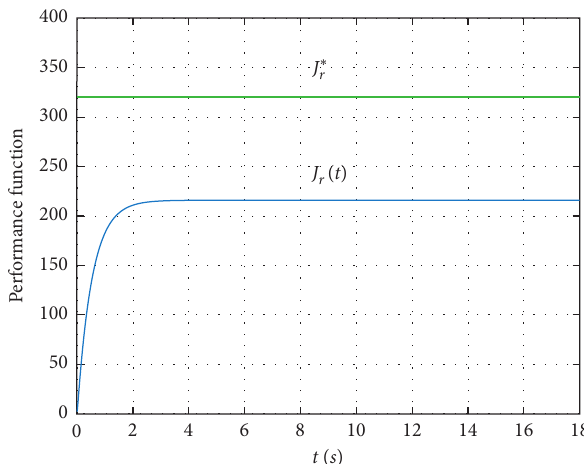
Figure 3: Performance function for static whole